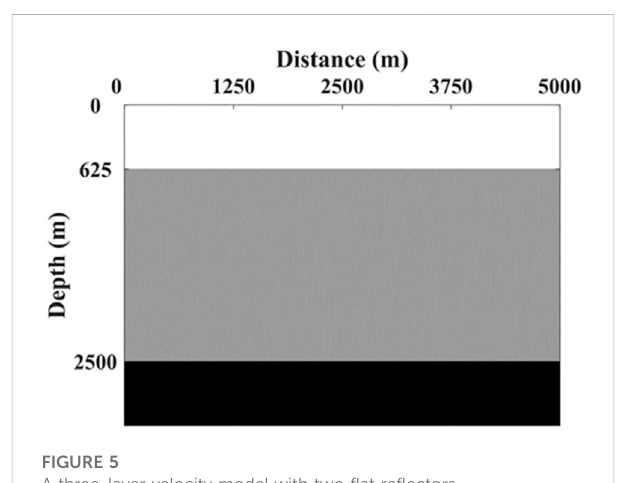
FIGURE 5 A three-layer velocity model with two fl at re fl